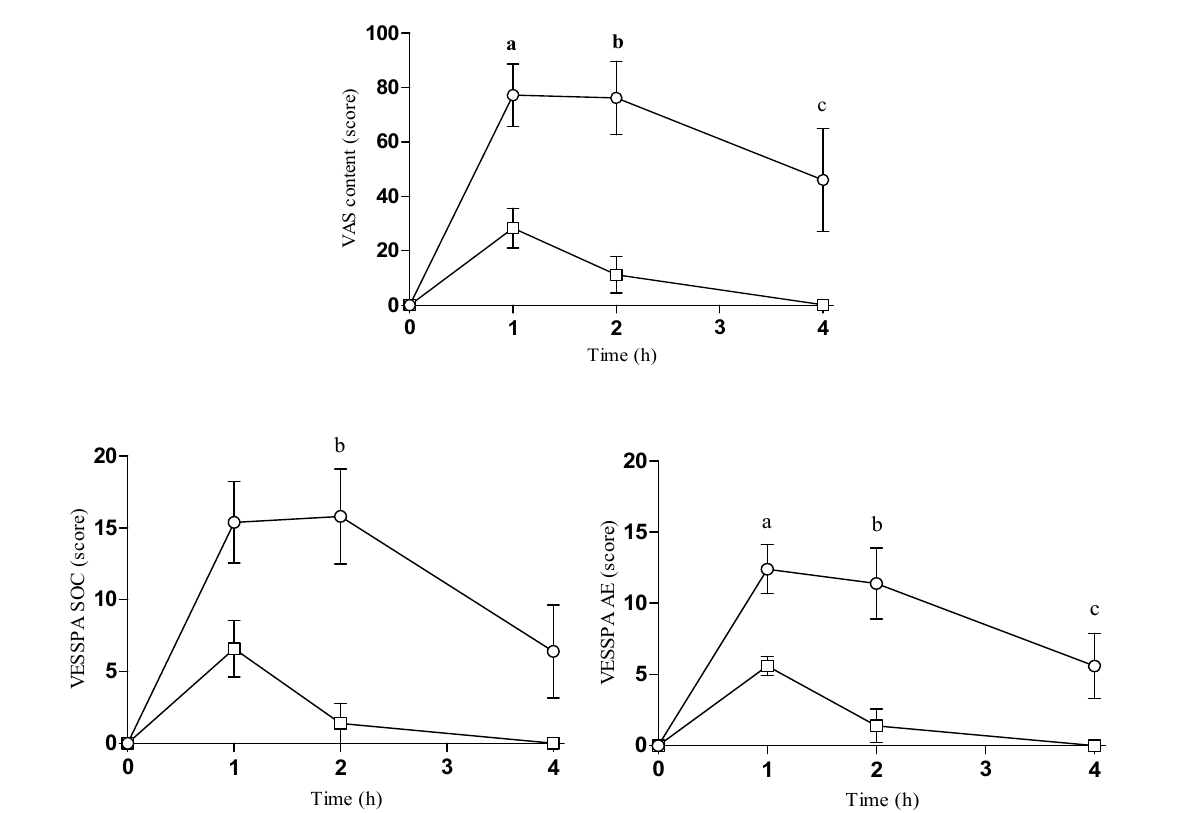
Figure 1. Summary of the course of physiological and subjective effects of mephedrone after oral and intranasal self- administration ( ○ oral mephedrone ( n = 5); □ intranasal mephedrone ( n = 5)). Statistical differences between oral and intranasal are presented as “a” p < 0.05, “ a ” p < 0.01 (time 1 h), “b” p < 0.05, “ b ” p < 0.01 (time 2 h), “c” p < 0.05, “ c ” p < 0.01 (time 4 h). See text for abbreviations.